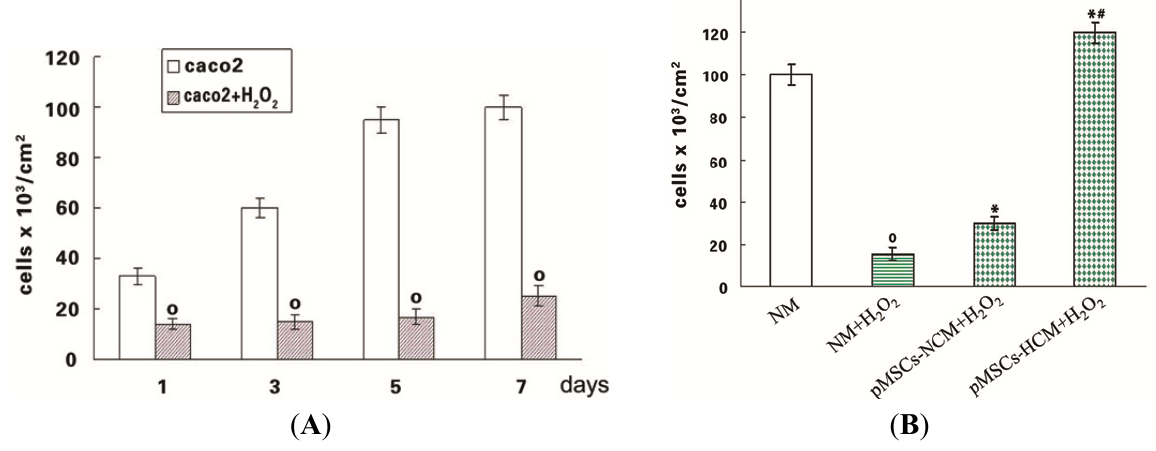
Figure 2. Protective effect of pMSCs-HCM on H cytotoxic effect on caco2 cell viability. Caco2 cells were incubated with H 12 h. After H O removal, cells were maintained in normal medium and viable cells were 2 2 counted after 1, 3, 5, 7 days; º p < 0.05 versus caco2 cells at the corresponding times ( n = 6); and ( B ) pMSCs-HCM has a better protective effect for H than that of pMSCs-NCM. Caco2 cells were incubated with 100 μ M H drug withdrawal, cells were cultured in normal medium, pMSCs-NCM, and pMSCs-HCM. Five days later, viable cells were counted by trypan blue staining; º p < 0.05 versus